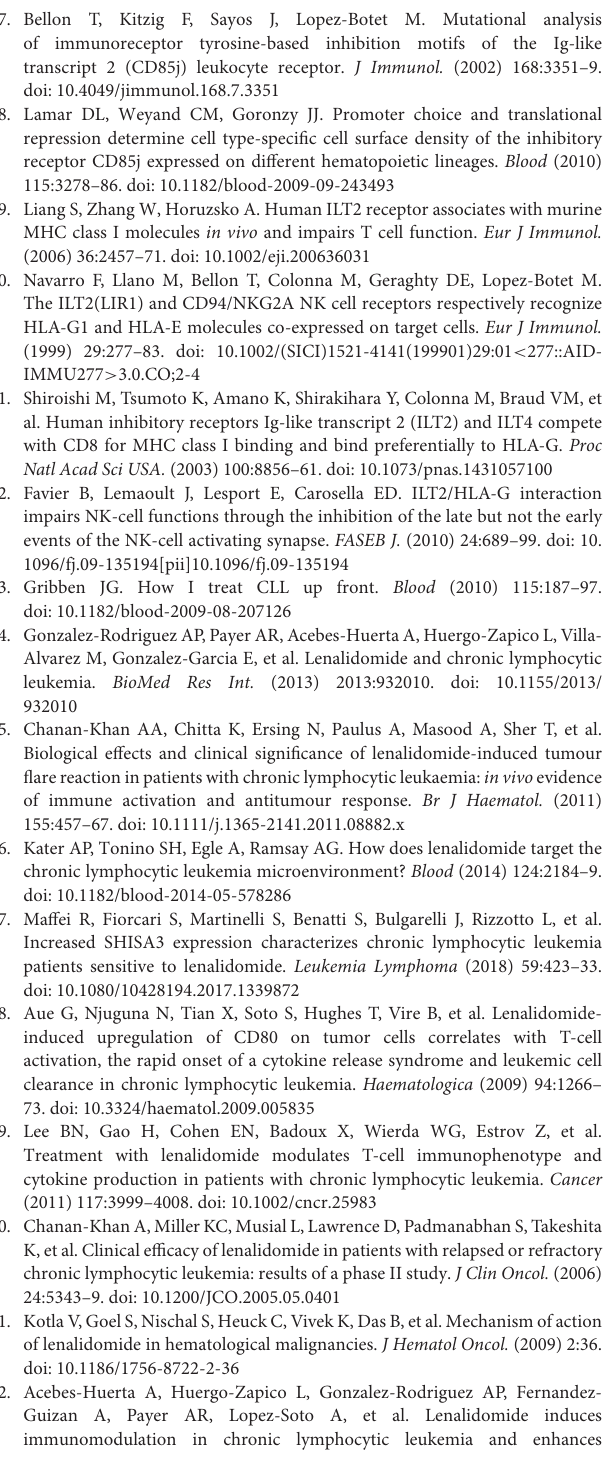
Figure 1S | Effect of ILT2 blockade and lenalidomide on the modulation of activation markers on NK cells. The figure shows the comparison between the surface expression of CD25 and CD137 (A) or NKG2D and DNAM-1 (B) on NK cells (CD3 − CD56 + ) from CLL patients ( n = 4) after treatment with anti-ILT2